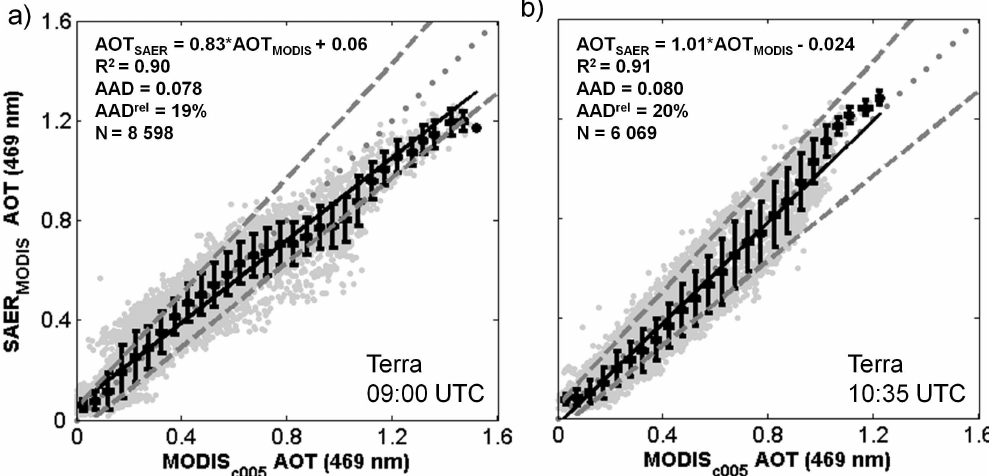
Fig. 10. Same as Fig. 9 but only for two Terra overpasses over Europe on 1 April 2007, at (a) 09:00UTC and (b)